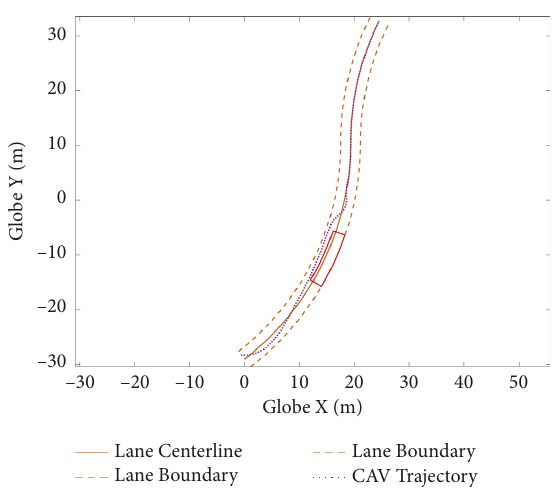
Figure 13: CAV trajectory with system